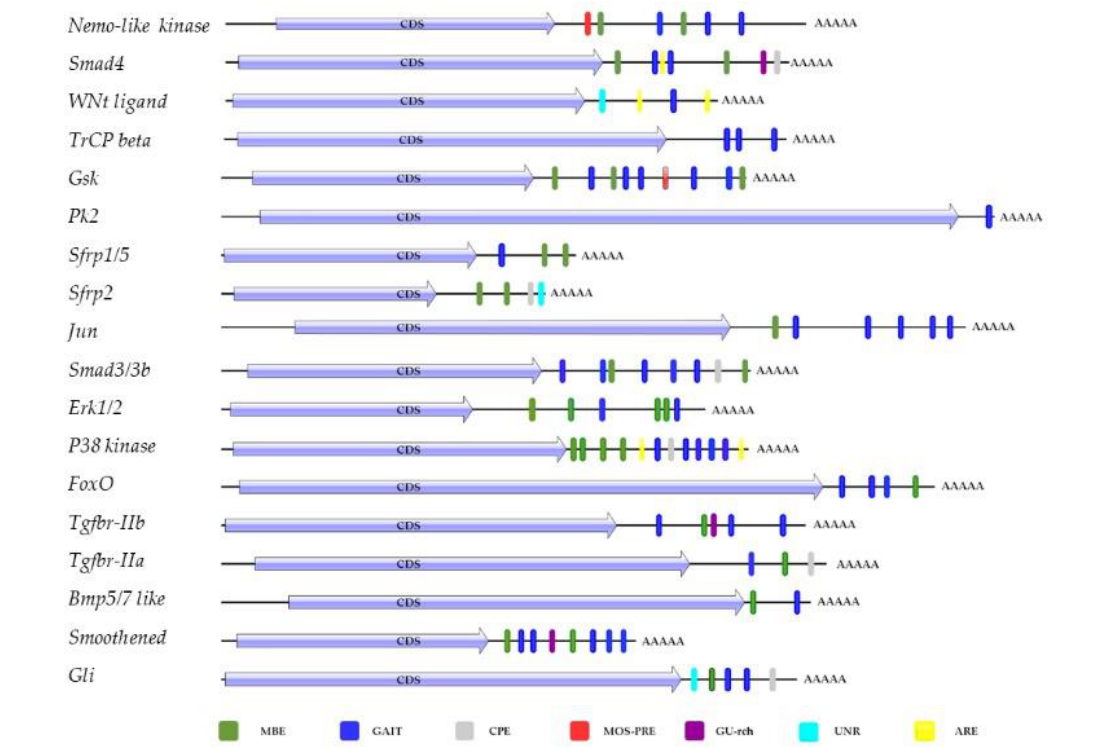
Figure 6. Analysis of 3′-UTR mRNA using the RegRNA web tool: MBE (musashi-binding element), GAIT (interferon-γ-activated inhibitor of translation), cytoplasmic polyadenylated element (CPE), MOS-PRE (polyadenylation response element), GU-rich destabilization element, RNA-binding protein (UNR), ARE (AU-rich element).